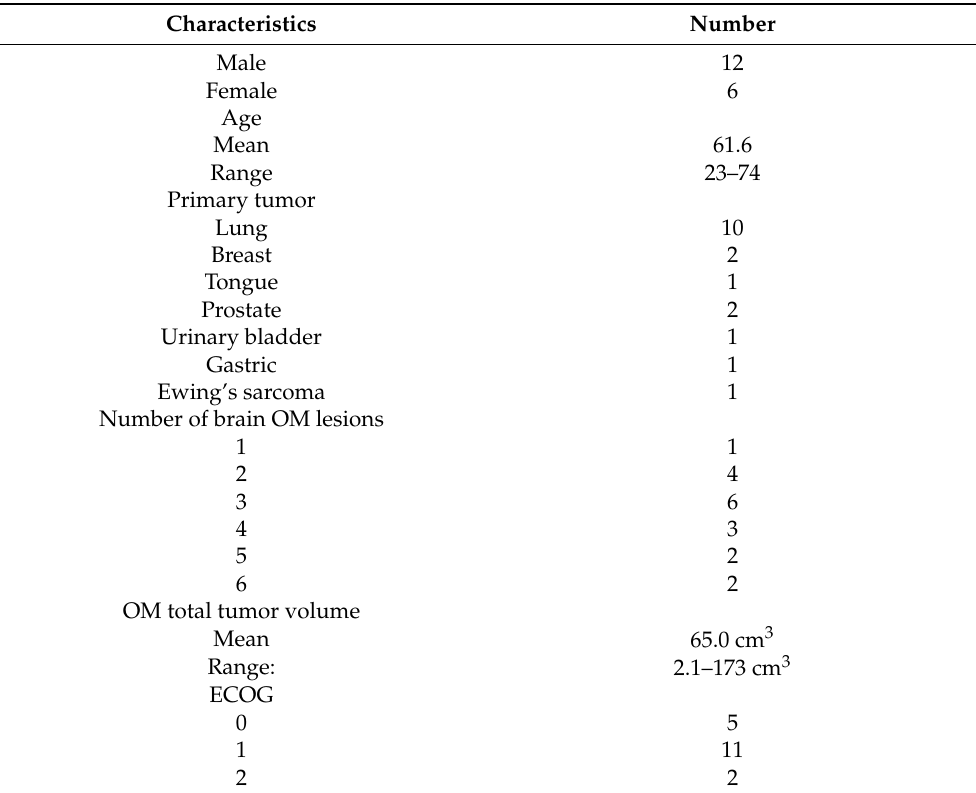
Table 1. Patient